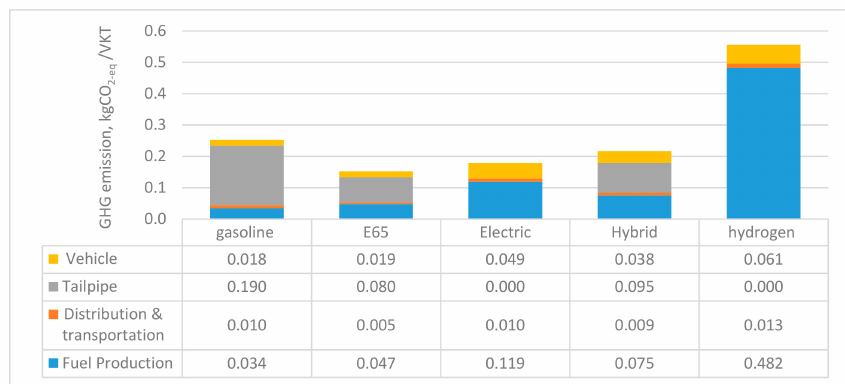
Figure 3. Life cycle GWP (kgCO 2-eq / VKT) for di ff erent fuel options.